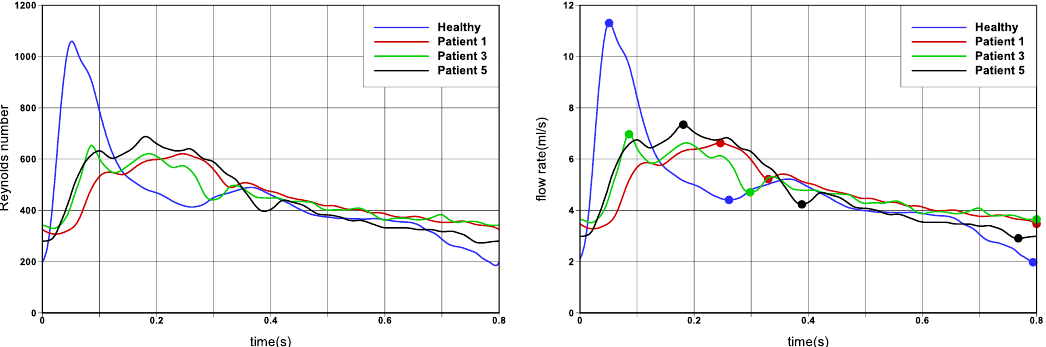
Figure 2. Inflow profiles obtained from [59], based on four subject datasets. The profiles from [59] were scaled to have mean Reynolds number of 450, as shown in the left plot. The right plot shows the flow rate profile for Case 6. Please note that the flow rate profiles for each Case will differ, due to geometric differences, however the Reynolds number profiles are the same for all Cases. The cardiac time period is approximately 0.8 s for each profile. The flow rate profile is marked with time instances, which approximately relate to peak systole ( t = 0.181 s), end systole (dicrotic notch) ( t = 0.389 s) and end diastole ( t = 0.768 s). Times in brackets are related to the waveform for Patient 5. Results of the numerical simulations are presented for these